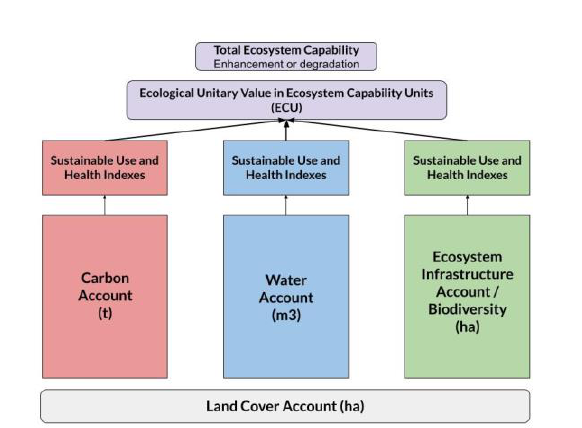
Figure 2. Overview of the Ecosystem Natural Capital Accounting (ENCA) Framework